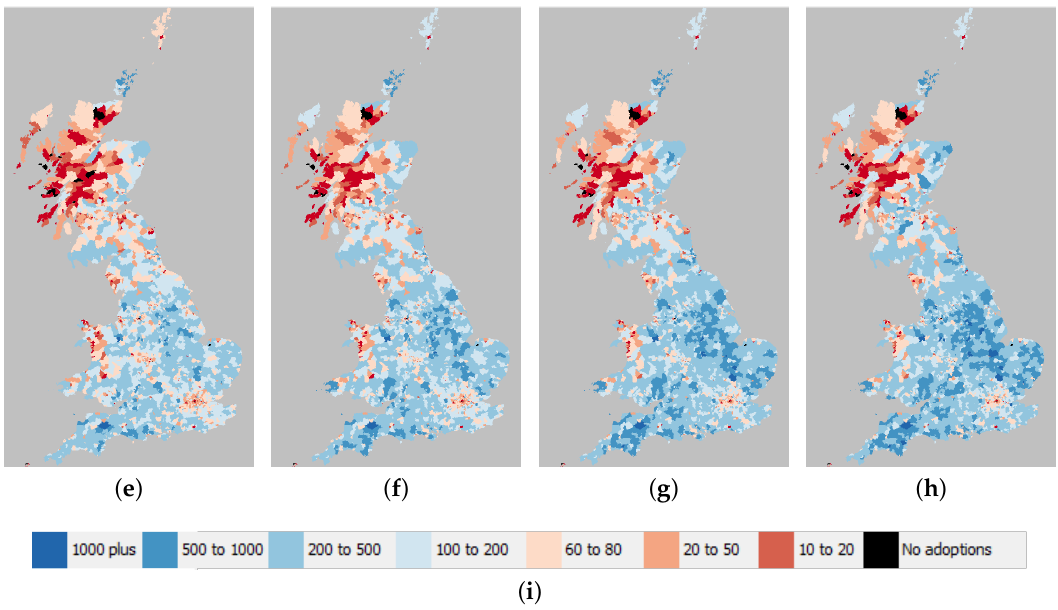
Figure 5. Snapshots of the distribution of the absolute number of domestic PV installations per postcode district (PCD) (per (A) in Section 3). ( a ) Snapshot of 1 April 2010; ( b ) Snapshot of 6 January 2011; ( c ) Snapshot of 30 June 2011; ( d ) Snapshot of 5 January 2012; ( e ) Snapshot of 3 January 2013; ( f ) Snapshot of 2 January 2014; ( g ) Snapshot of 1 January 2015; ( h ) Snapshot of 30 September 2015; ( i ) Key: number of installations per